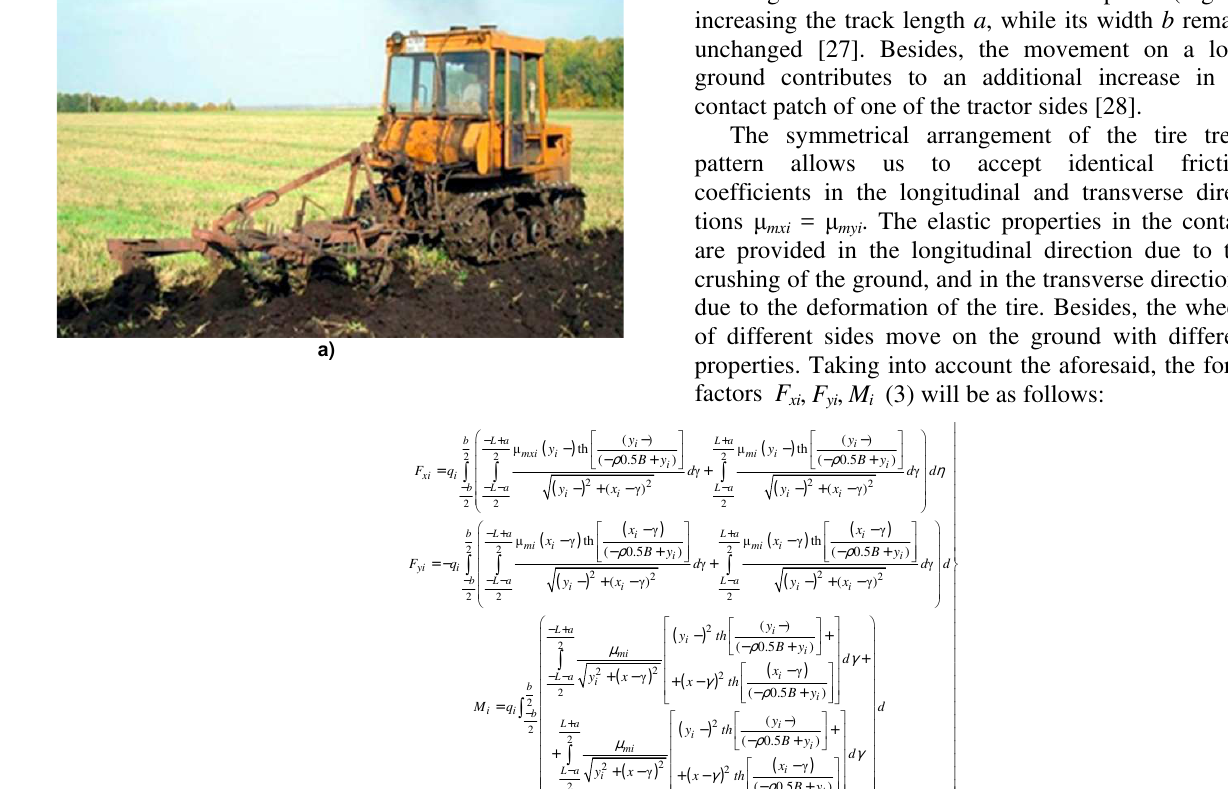
where the “+” sign is used for the lower side moving in the furrow, the “–” sign is used for the upper side moving along the virgin soil; α is the tilt angle of the tractor, h is the height of the tractor’s center of mass; ab is the length and width of the wheel track. The lateral tilt of a wheeled tractor leads to a redistribution of the weight load between the sides